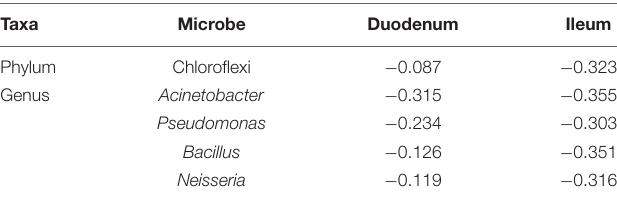
gastrointestinal tract, and composition of the feed (Pan and Yu, 2014; Mancabelli et al.,